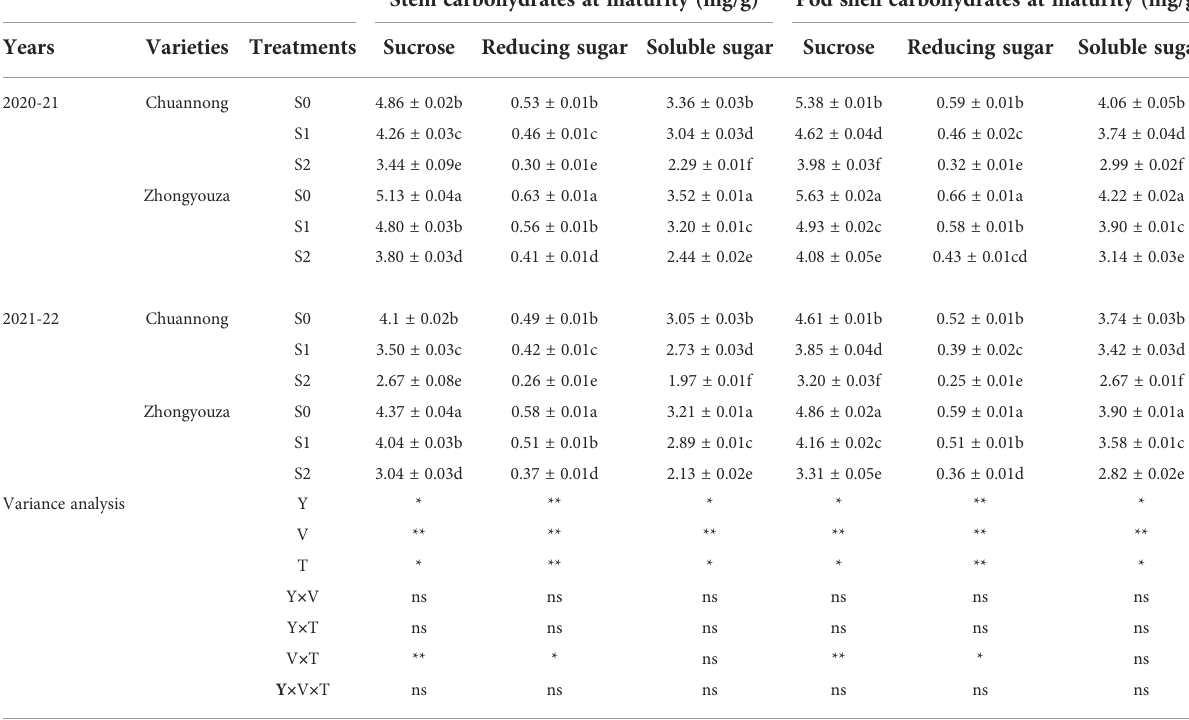
TABLE 3 Effect of shading on carbohydrates content of rapeseed at